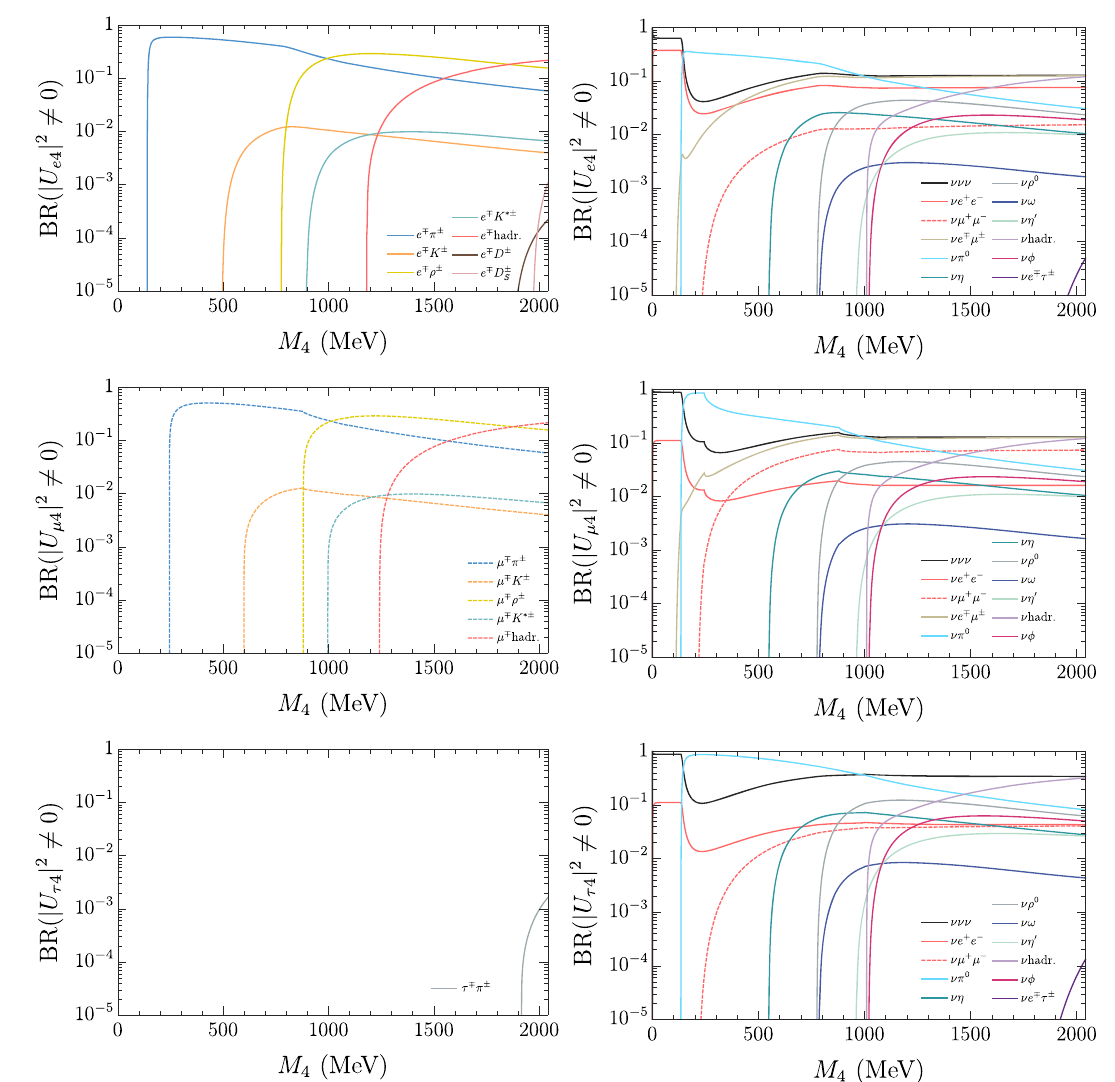
Fig. 2 Branching ratios for the heavy N 4 as a function of its mass, obtained under the assumption that only its mixing to one lepton flavor is non-zero, as indicated by the labels in each row. Left (right) panels correspond to decays without (with) light neutrinos in the final state.